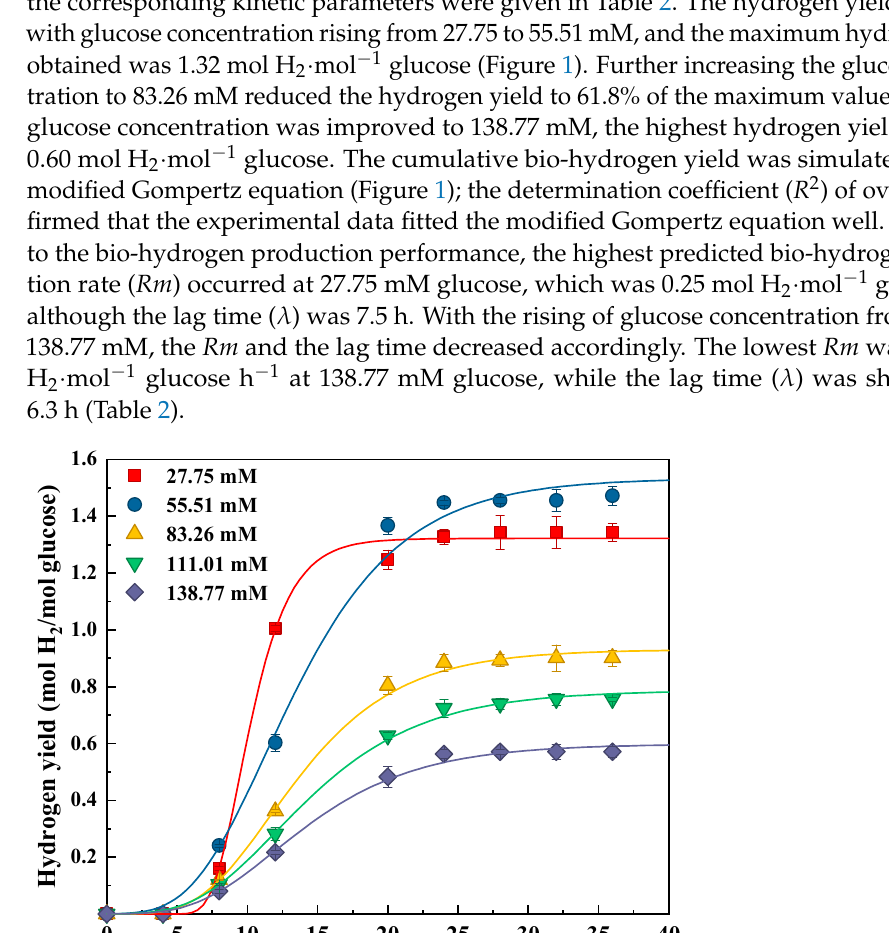
Figure 2. Cumulative bio-hydrogen yield from xylose at varying substrate concentrations with sim- ulation curves based on the modified Gompertz equation.